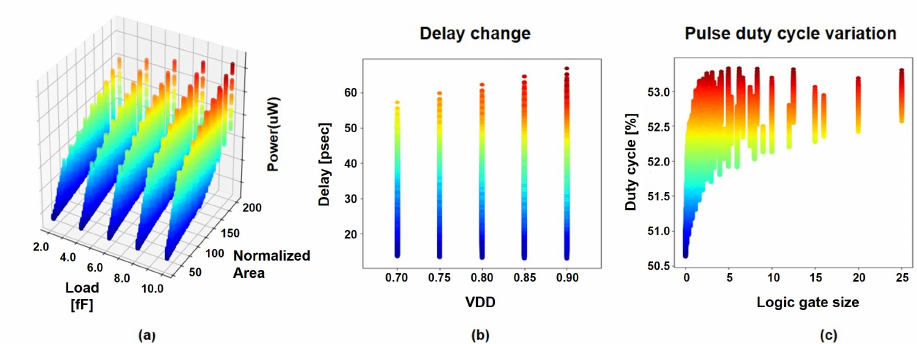
Figure 8. ( a ) Evaluated area/power dissipation/load (parasitic) relationship of the SAR ADC timing controller, ( b ) delay change, and ( c ) pulse duty cycle